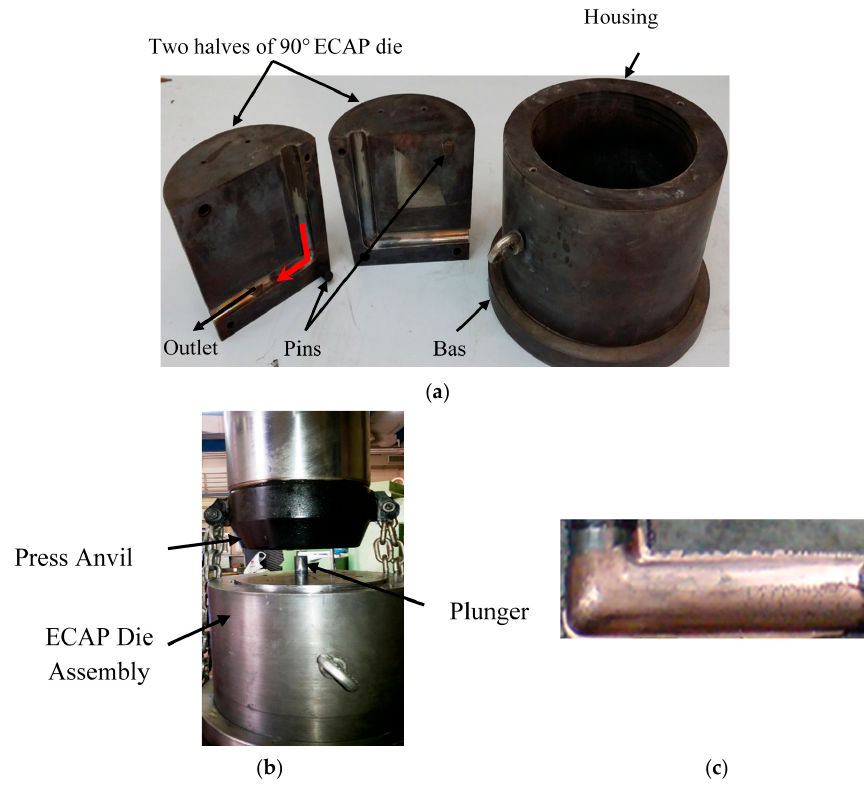
Figure 1. Setup of ECAP process; ( a ) Details of ECAP die; ( b ) Pressing; ( c ) Copper sample after four ECAP passes.